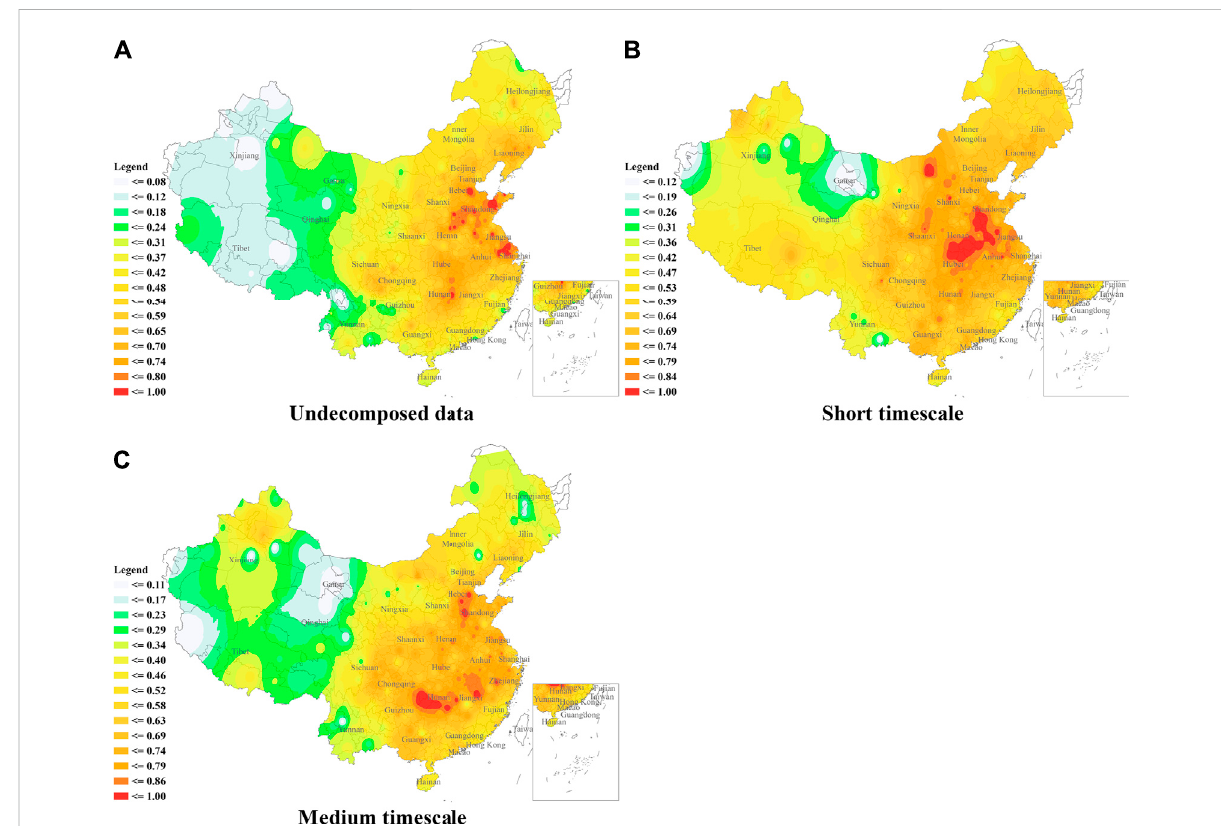
Thehotspotmapsofspilloverimpact(SI)ofairpollution.Allcities ’ SIsoneachtimescalearedrawnasahotspotmap.Panels (A – C) aretheresults of the undecomposed data, the short timescale, and the medium timescale, respectively, where we use CC, WOD, and WOD as proxies for SI values ofcities,respectively.ThevalueofeachcityistheaveragevalueofSIacrossallwindowsforthecity.Tobetterdisplaythediscretepointobjectsinthe map,weapplyaninversedistanceweightingmethodtointerpolatetheSIvaluesspatially.Thevaluesarenormalizedtoarangeof0 – 1.Wedivide the SI values into 15 segments using the Jenks natural breaks classi fi cation method and set a different color for each segment, with regions having a large SI represented in red and a small SI in